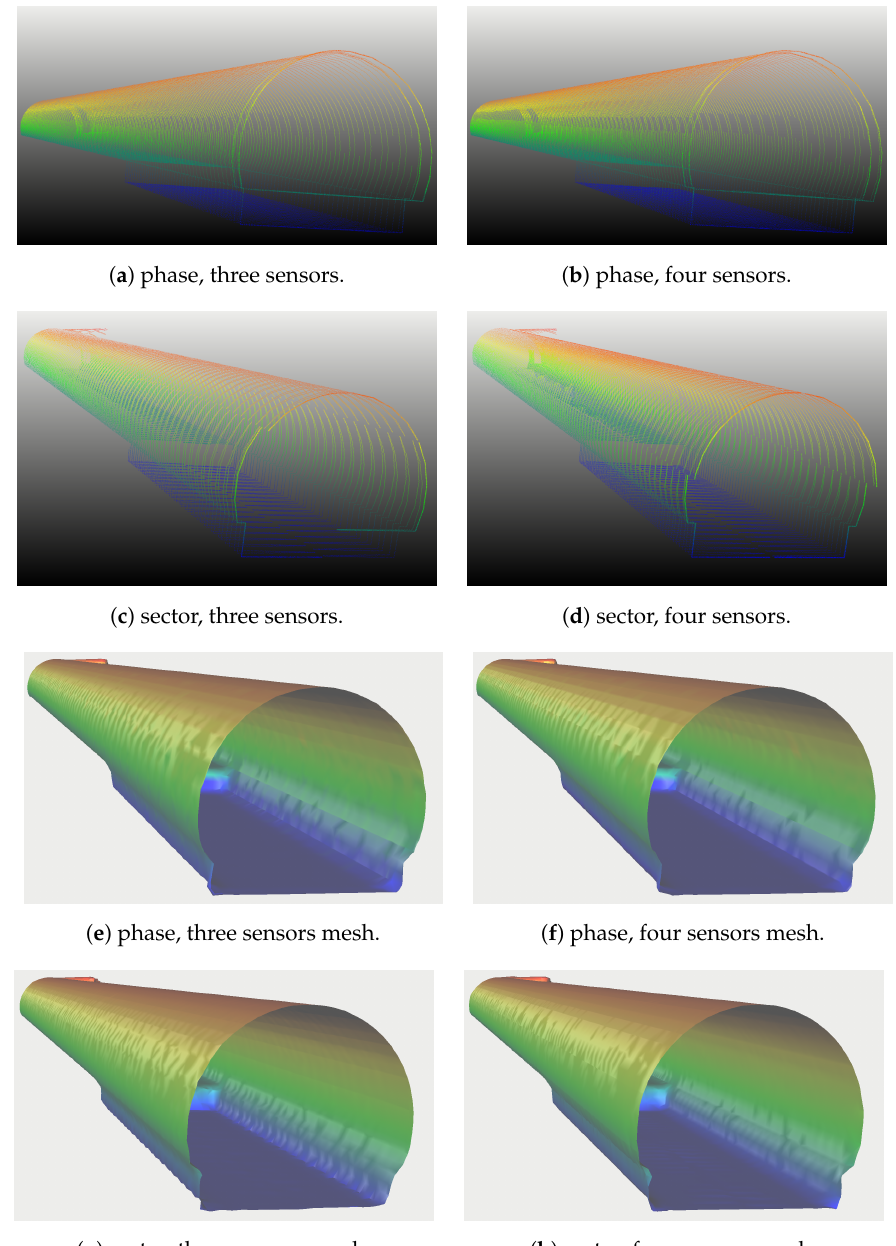
Figure 13. The problem with occlusions in the phase shift approach is shown in ( a , b ) when using sensors side by side, for the MEDIUM configuration of the 881L sensor, which makes it easier to see the resulting sampling of both approaches. Note the reading gaps at the side walls. The space between sensors also results in gaps in the sector approach, the gap is smaller on side walls than the phase shift approach, see ( c , d ). Comparing figure ( a ) with ( c ) and figure ( b ) with ( d ), the resolution difference between the two approaches. The resulting meshes for the phase shift and sector approaches for three and four sensors are shown in ( e , f ) and ( g , h ), respectively. The phase shift approach for three and four sensors shows aliasing at the side walls at the occlusions, but there is little aliasing at the floor for three and four sensors. Note the aliasing in ( g ), for sector offset for three sensors shown at the regions in blue next to the floor, while the mesh reconstruction algorithm can decrease the aliasing when using four sensors in ( h ). Also aliasing at side walls seems to be smaller for the sector offset than the phase shift